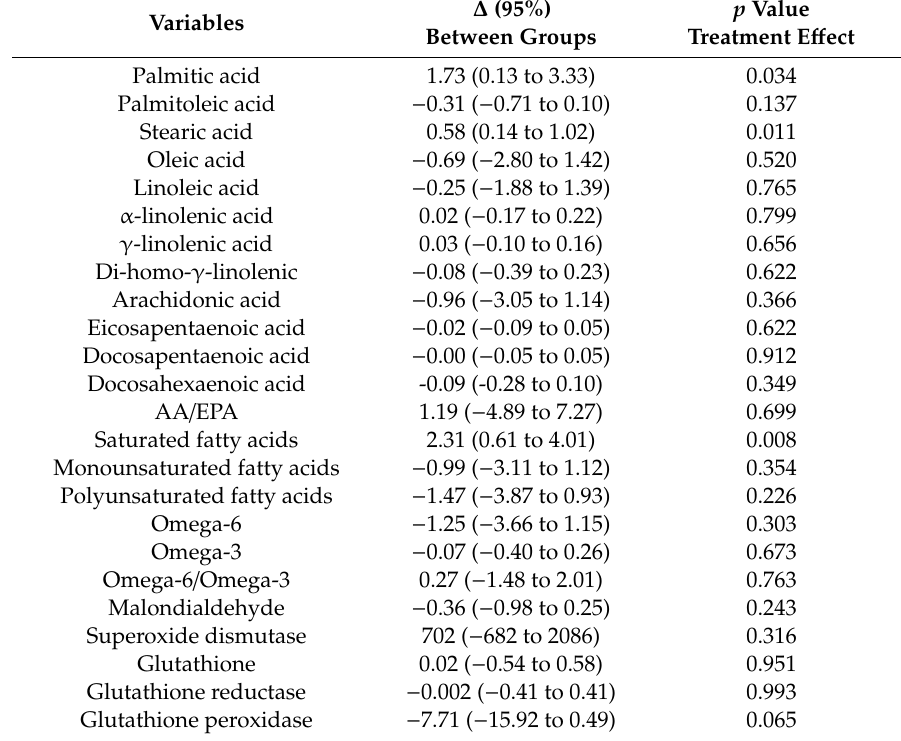
Table 4. Between group di ff erences on plasma fatty acids and oxidative stress markers of the sarcopenic elderly. The placebo group was under a controlled diet and performs physical activity, while the supplemented group also takes the dietary supplement ( n = 69 in the supplementation group, n = 61 in the placebo